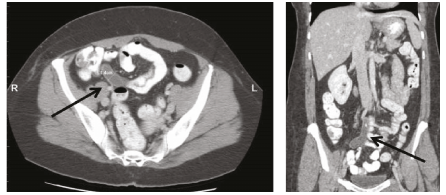
Figure 1: CT scan: appendix mucocele